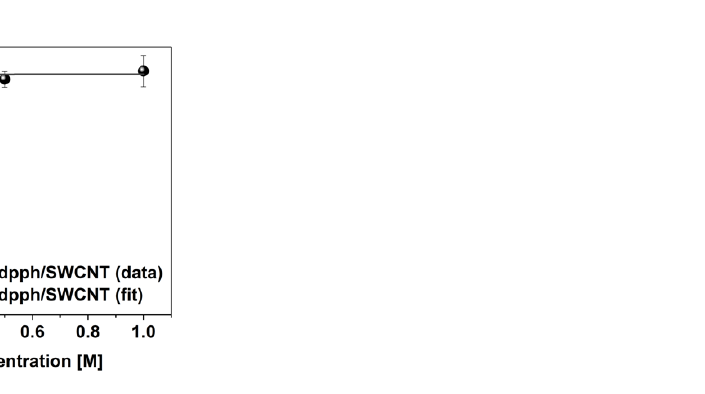
Figure 6. Electrical conductivity values of the SWCNT films before and after doping with dpph as a function of dopant concentration.